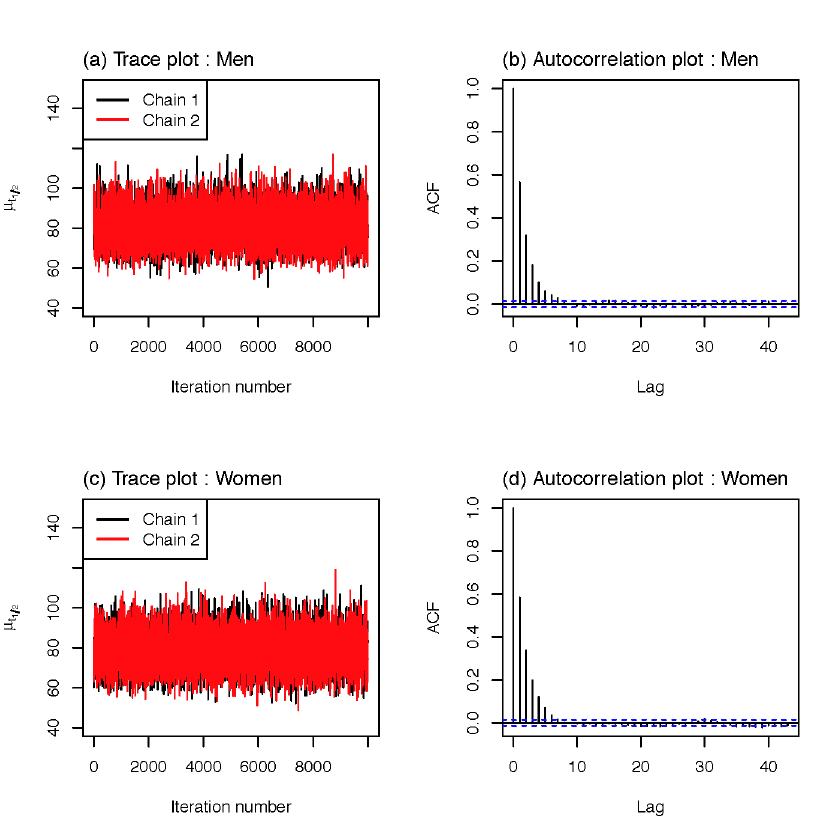
Figure 1. Diagnostic plots of MCMC outputs for population half-life; ( a ) trace plot and ( b ) autocorrelation plot for men, and ( c ) trace plot and ( d ) autocorrelation plot for